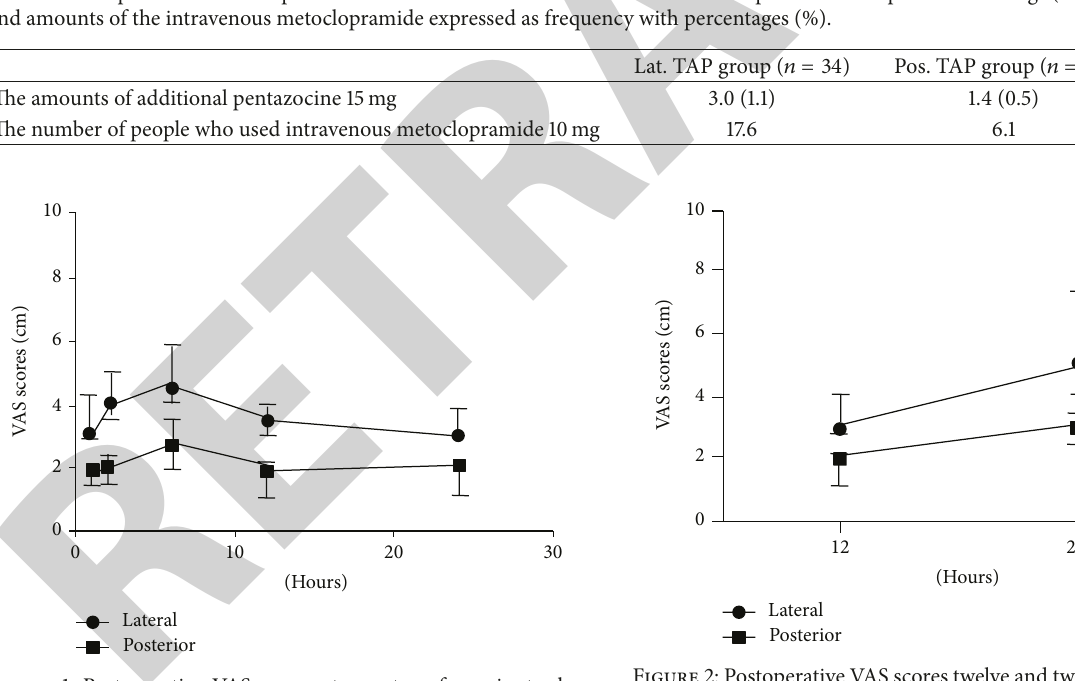
Figure 1: Postoperative VAS scores at one, two, four, six, twelve, and twenty-four postoperative hours during rest: data expressed as a median (twenty-fifth to seventy-fifth percentiles).